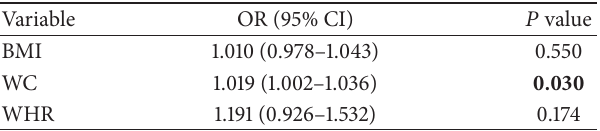
Table 2: Associations of anthropometric measures with chronic kidney disease in patients with type 2